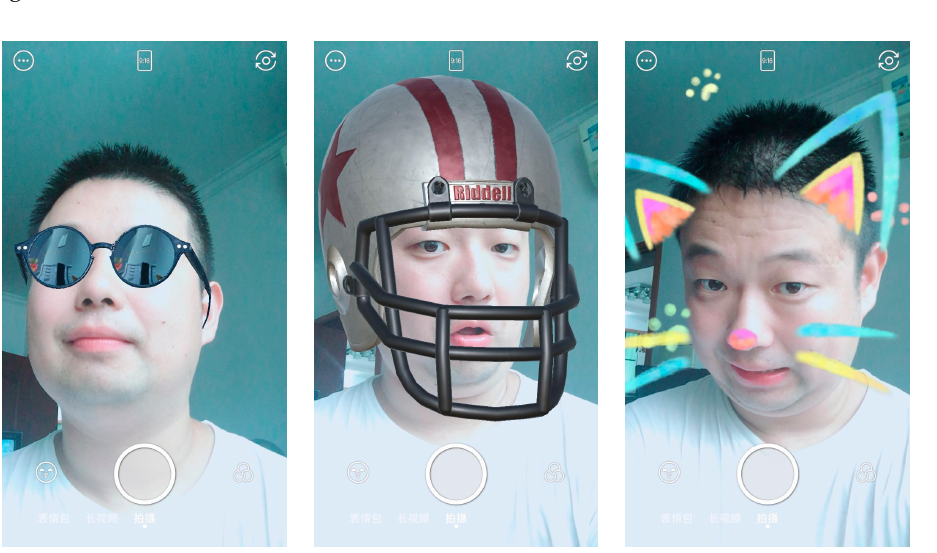
Figure 14. Sample AR (Augmented Reality) effects of the mobile application using our proposed compressed model version of SDM.